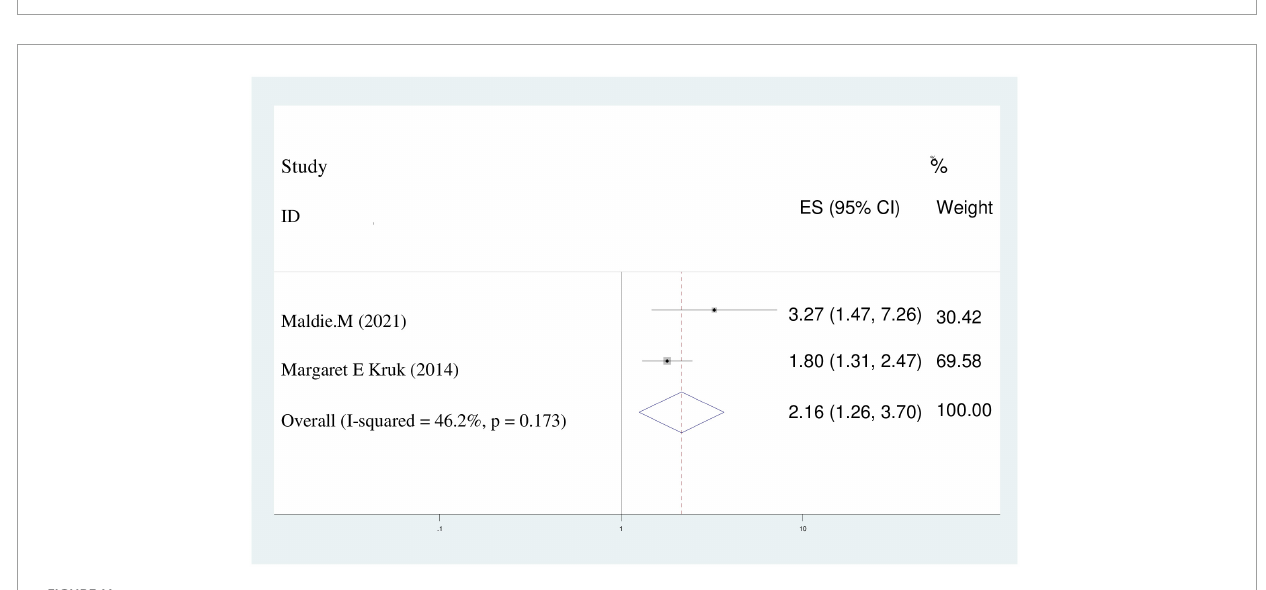
FIGURE11 Pooled odds ratio displaying the association of poor wealth index with disrespect and abuse of women.